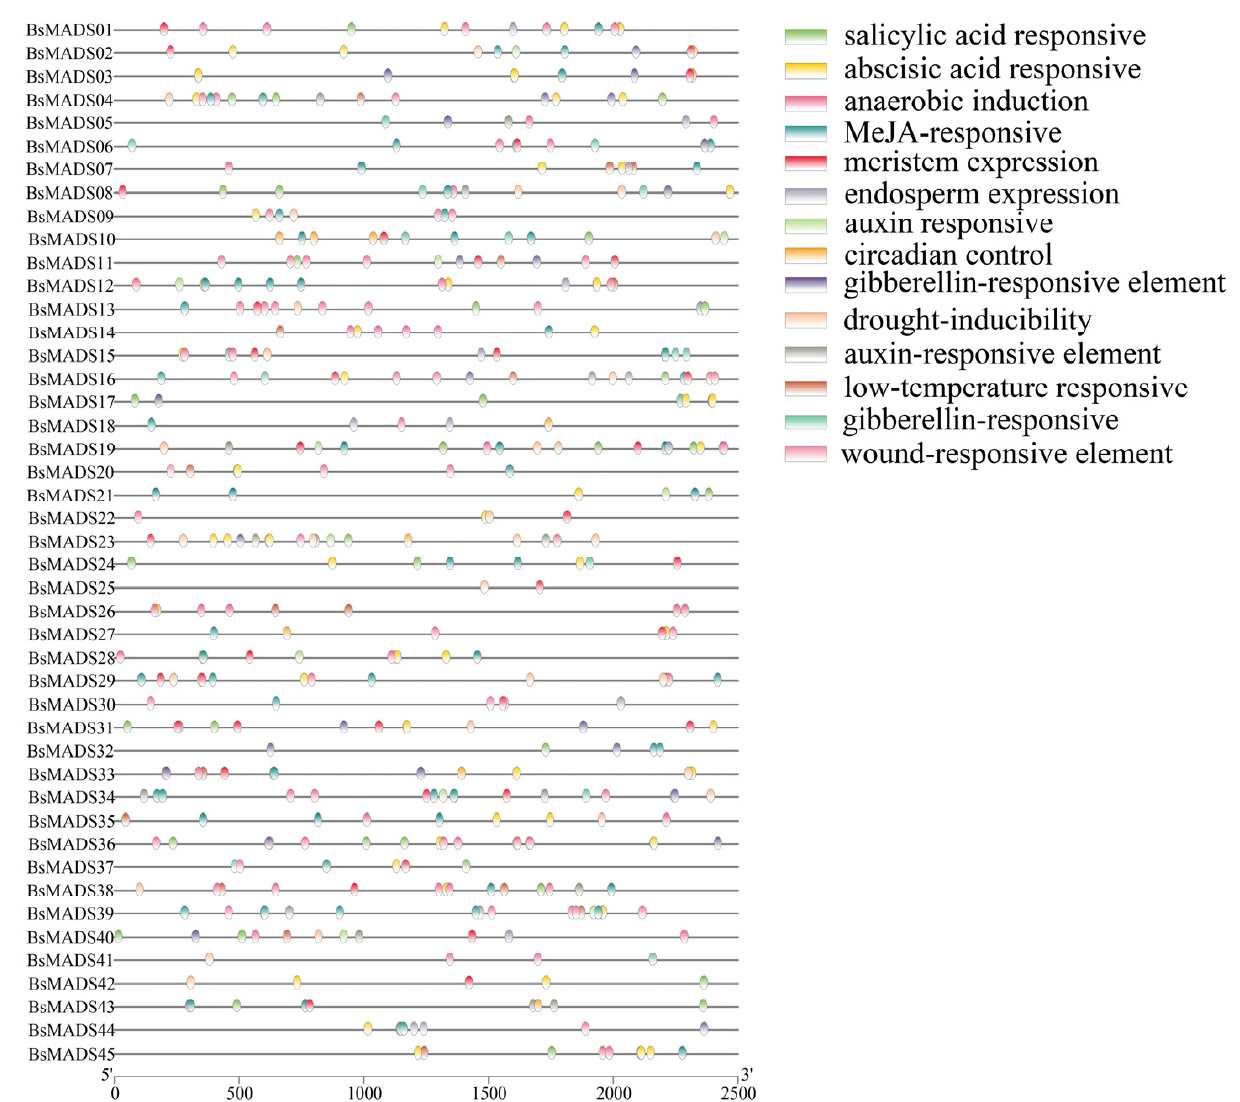
Figure 2. Distribution of various cis -acting elements in the promoter regions of B. striata MADS genes ( BsMADSs ). The cis -elements of the BsMADSs were searched using the online PlantCARE website. Special cis -acting elements were selected (e.g., auxin-responsive elements), and TBtools was used to create the diagrams.